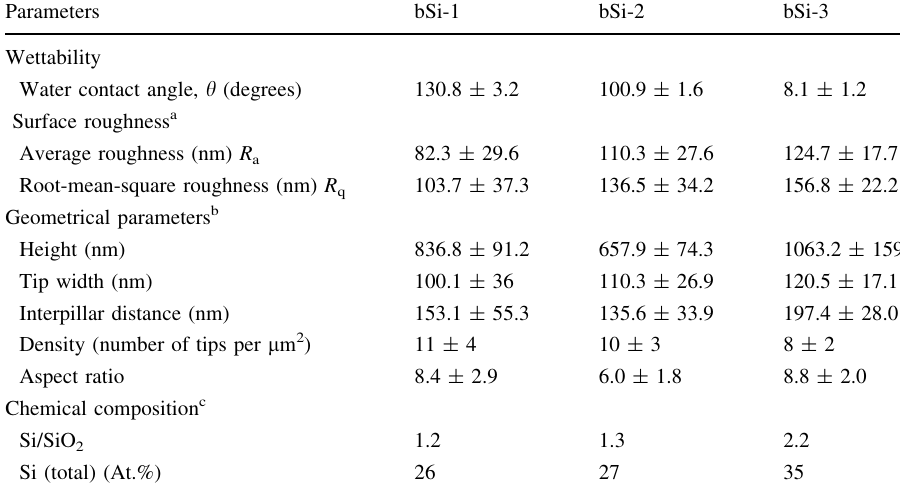
Table 1 Summary of surface wettability, surface roughness analysis and geometrical parameters of nanopillars of the bSi